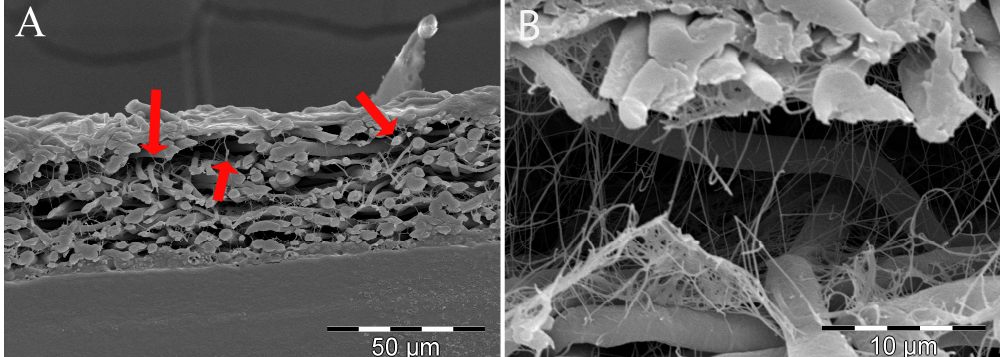
Figure 2. SEM images showing two different magnifications of the cross-section of BC/PLA nanocomposites. ( A ) The arrows indicate the presence of fibers along the thickness of the PLA mats. ( B ) Higher magnification image of BC/PLA/Lip nanocomposite.